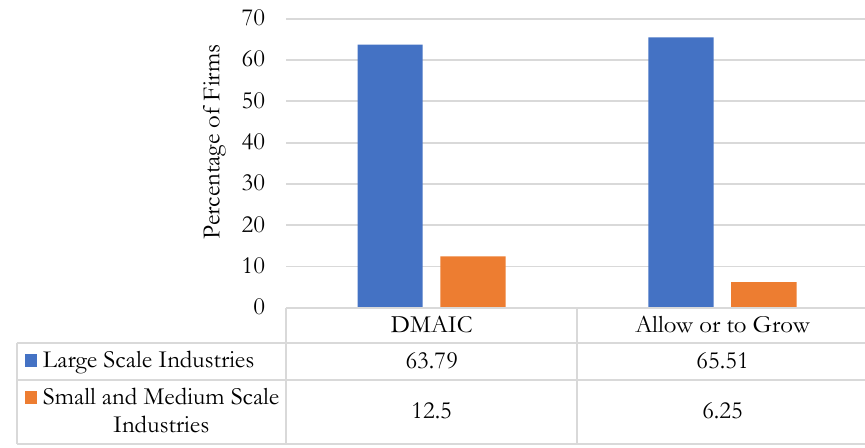
Fig. 6. Comparison of LEAN Manufacturing tools between two groups.